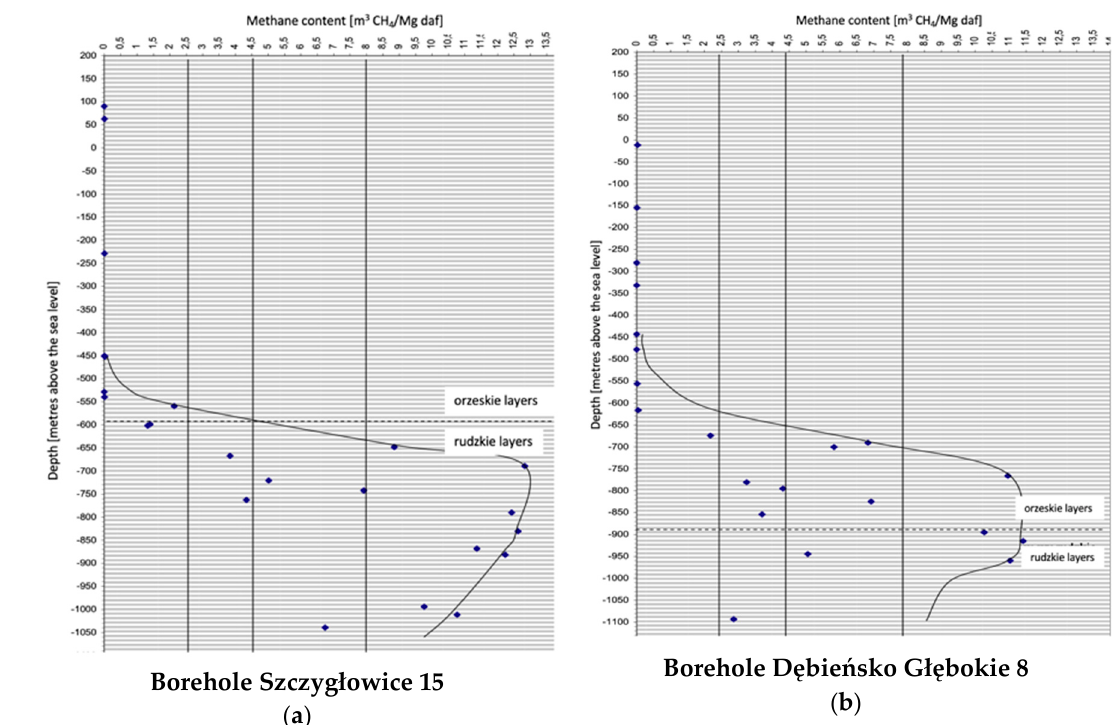
Figure 2. The distribution of methane content according to depth within a selected area: ( a ) Description for borehole Szczyg ł owice borehole; ( b ) description for borehole D ę bi ń sko G łę bokie 8 [9].